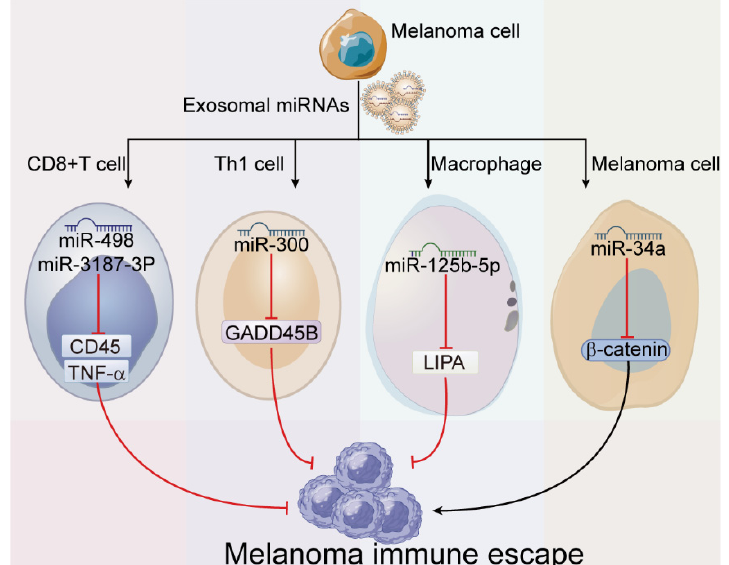
Figure 6. Roles of exosome-derived miRNAs in melanoma immune escape. MiRNAs derived from melanoma exosomes could suppress the abilities of CD8 + T cells and Th1 cells to target and attack melanoma cells, encourage the development of tumor-associated macrophages, and reduce the antitumor immunity of melanoma, all of which ultimately contribute to immune escape.